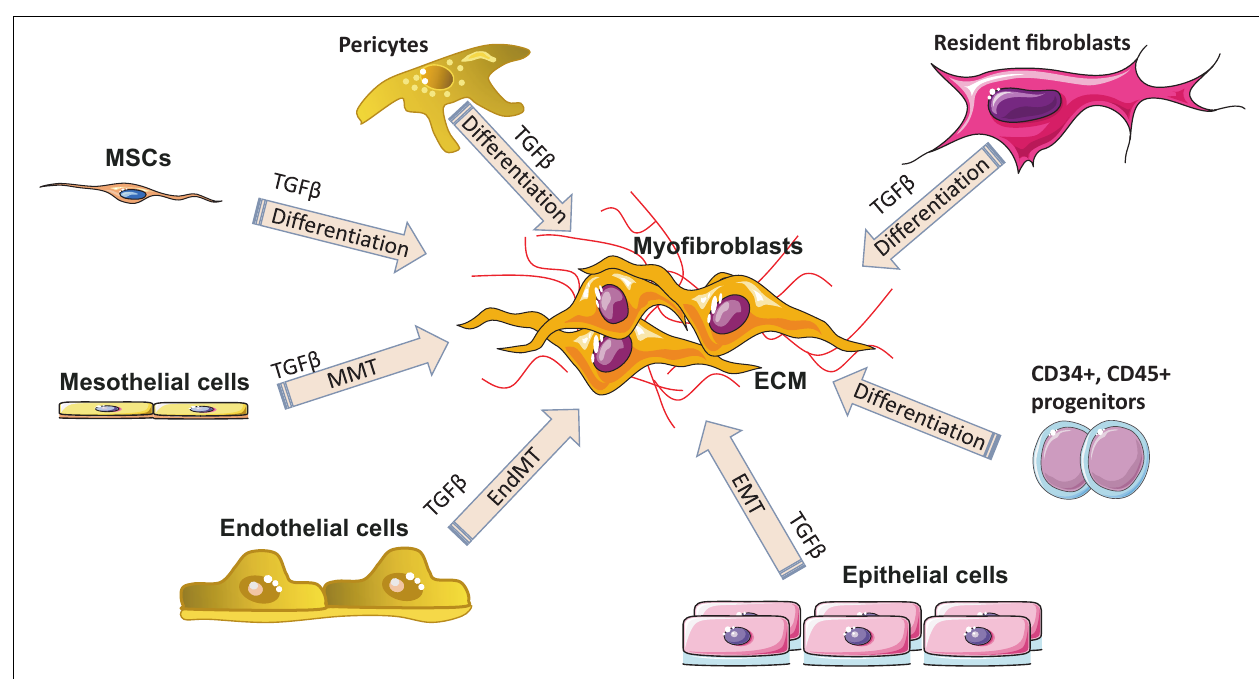
FIGURE 4 | Myofibroblast origin in fibrosis. Resident fibroblasts, pericytes, circulating progenitor cells (CD34 + , CD45 + , bone marrow–derived mesenchymal stem cells (MSC) transition, mesothelial cells undergoing mesothelial-to-mesenchymal transition (MMT), epithelial cells undergoing epithelial to mesenchymal transition (EMT) and endothelial cells undergoing endothelial-mesenchymal transdifferentiation (EndMT) are all known sources of myofibroblasts in various fibrotic diseases. ECM, extracellular matrix; TGF- β , transforming growth factor- β .